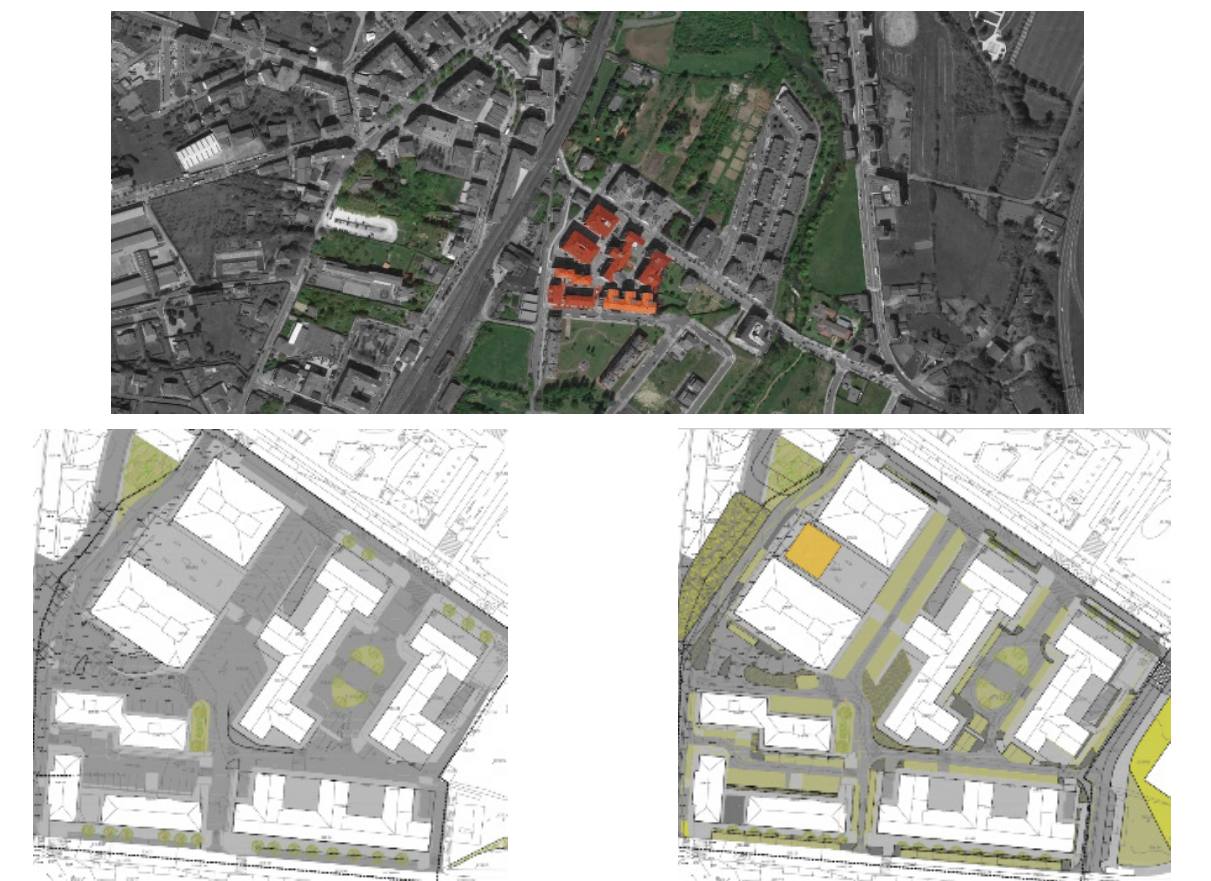
Figure 10. Scheme of the Legazpi’s green urban infrastructure project (developed by the authors).